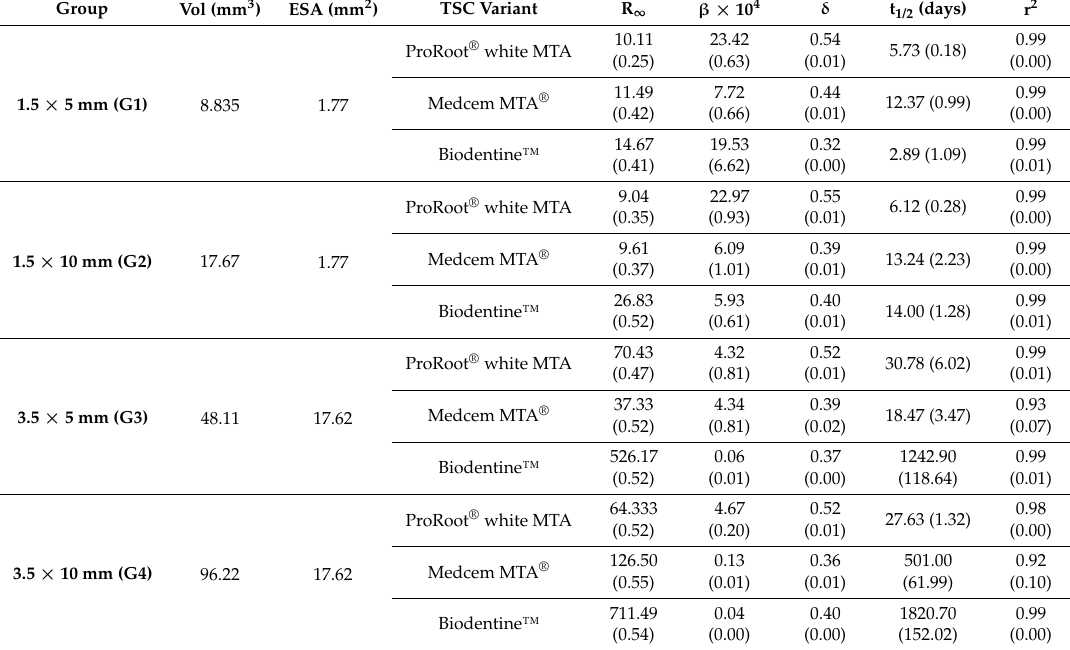
Table 5. Values of the parameters of the Equation (1), t 1/2 and r 2 with corresponding standard deviation ( n = 6) between parentheses for the cumulative calcium release of the TSCs as a function of sample